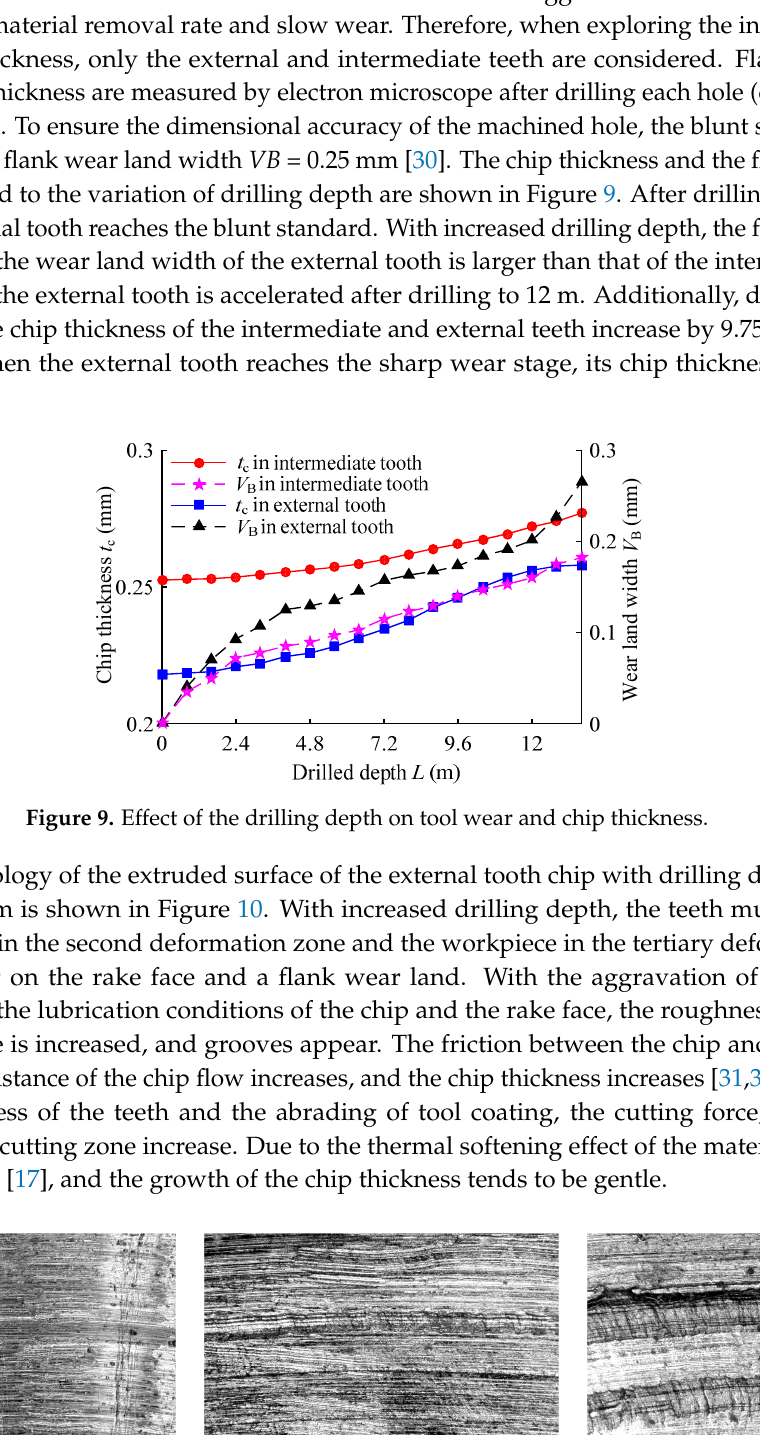
( b ) Figure 8. The effect of drilling process parameters on chip thickness: ( a ) under different drilling feeds at a speed of 1200 r/min; ( b ) under different drilling speeds at a feed of 0.1 mm/r. Compared with the external and intermediate teeth in the staggered teeth BTA drill, the central tooth has a low material removal rate and slow wear. Therefore, when exploring the influence of drill wear on chip thickness, only the external and intermediate teeth are considered. Flank wear land width and chip thickness are measured by electron microscope after drilling each hole (depth